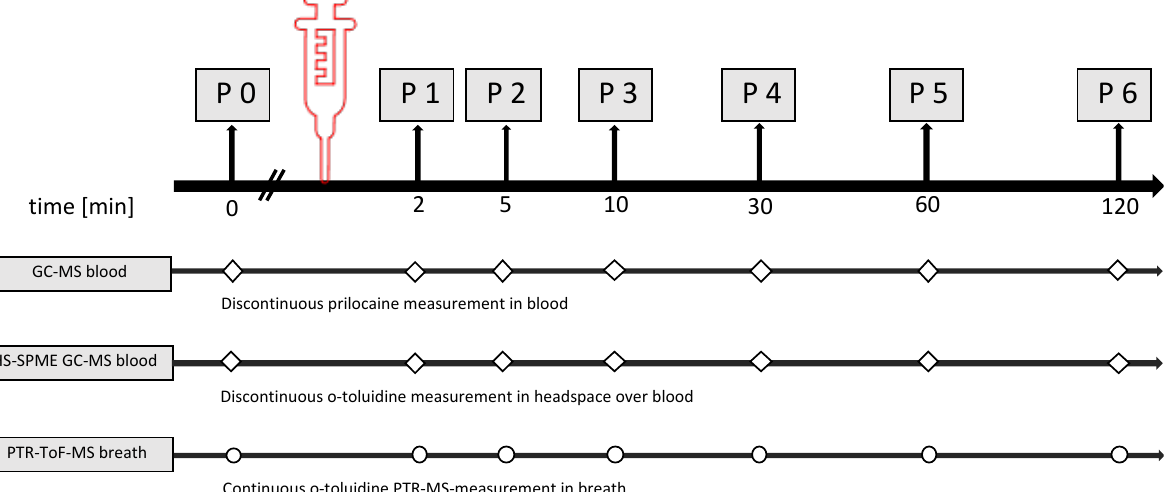
Figure 4. Schedule of the experimental procedures for both study groups (group A: intravenous injection group B: regional anaesthesia/infiltration). Discontinuous measurements in blood (squares) were carried out for prilocaine by GC-MS and for o-toluidine in the headspace over blood by HS-SPME-GC-MS. Continuous monitoring of breath gas was performed by PTR-TOF-MS (dots).